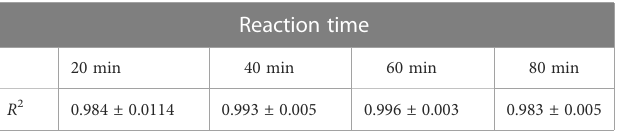
TABLE 1 The R 2 value at various reaction times ( n = 4).